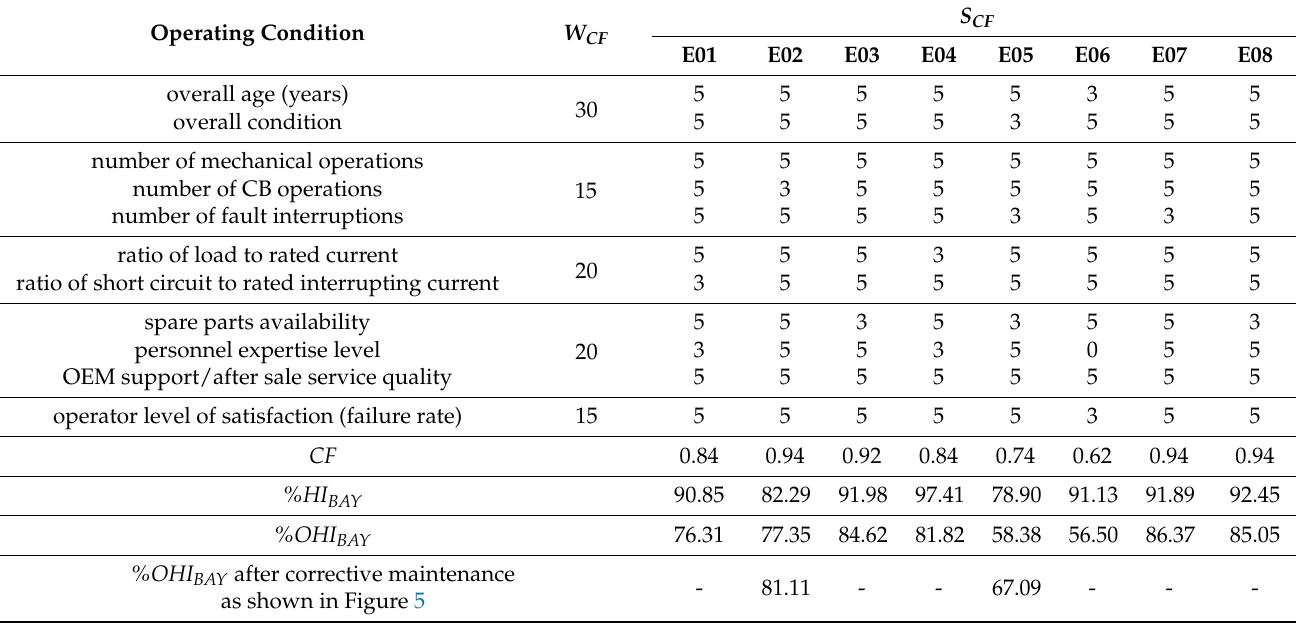
Table 12. Conditional factor evaluation and overall bay health index